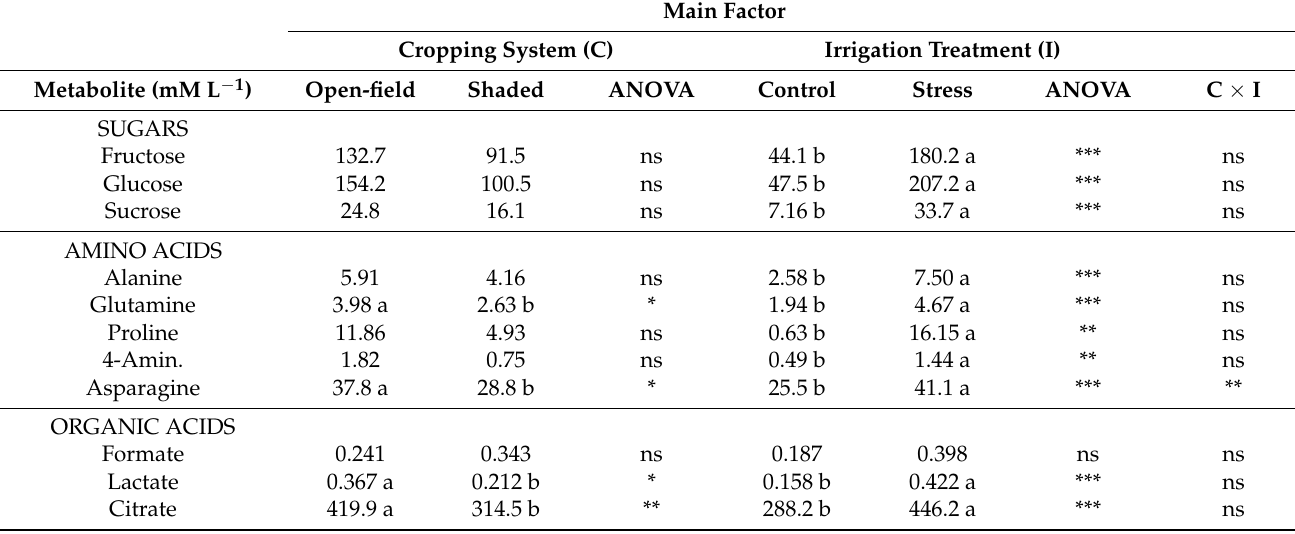
Table 5. Analysis of variance (ANOVA) of metabolite content (sugars, amino acids, and organic acids) in lime juice, as affected by cropping system and irrigation